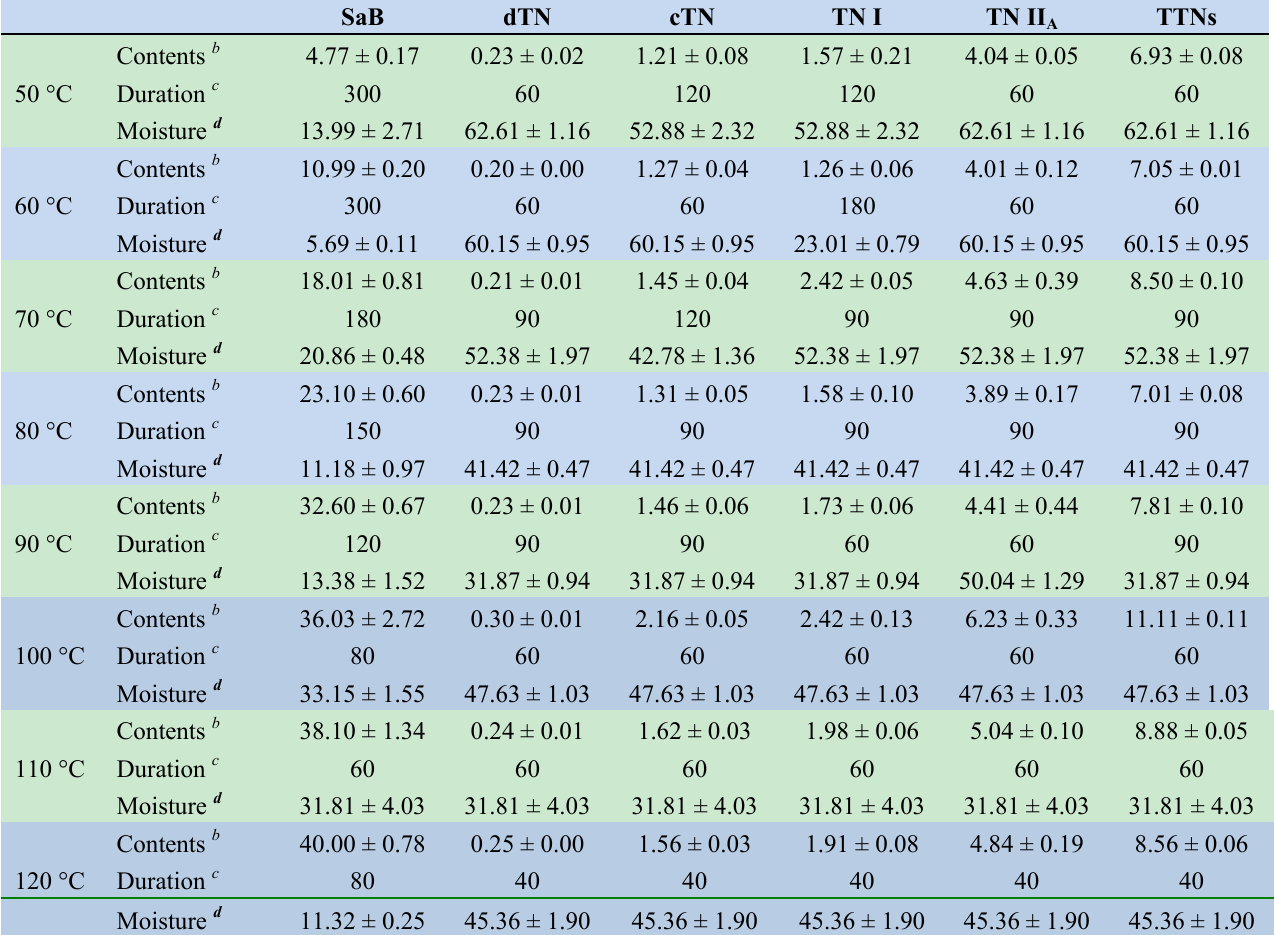
Table 2. The apical values of five analytes in Danshen (A-values) and their corresponding moisture and drying duration a